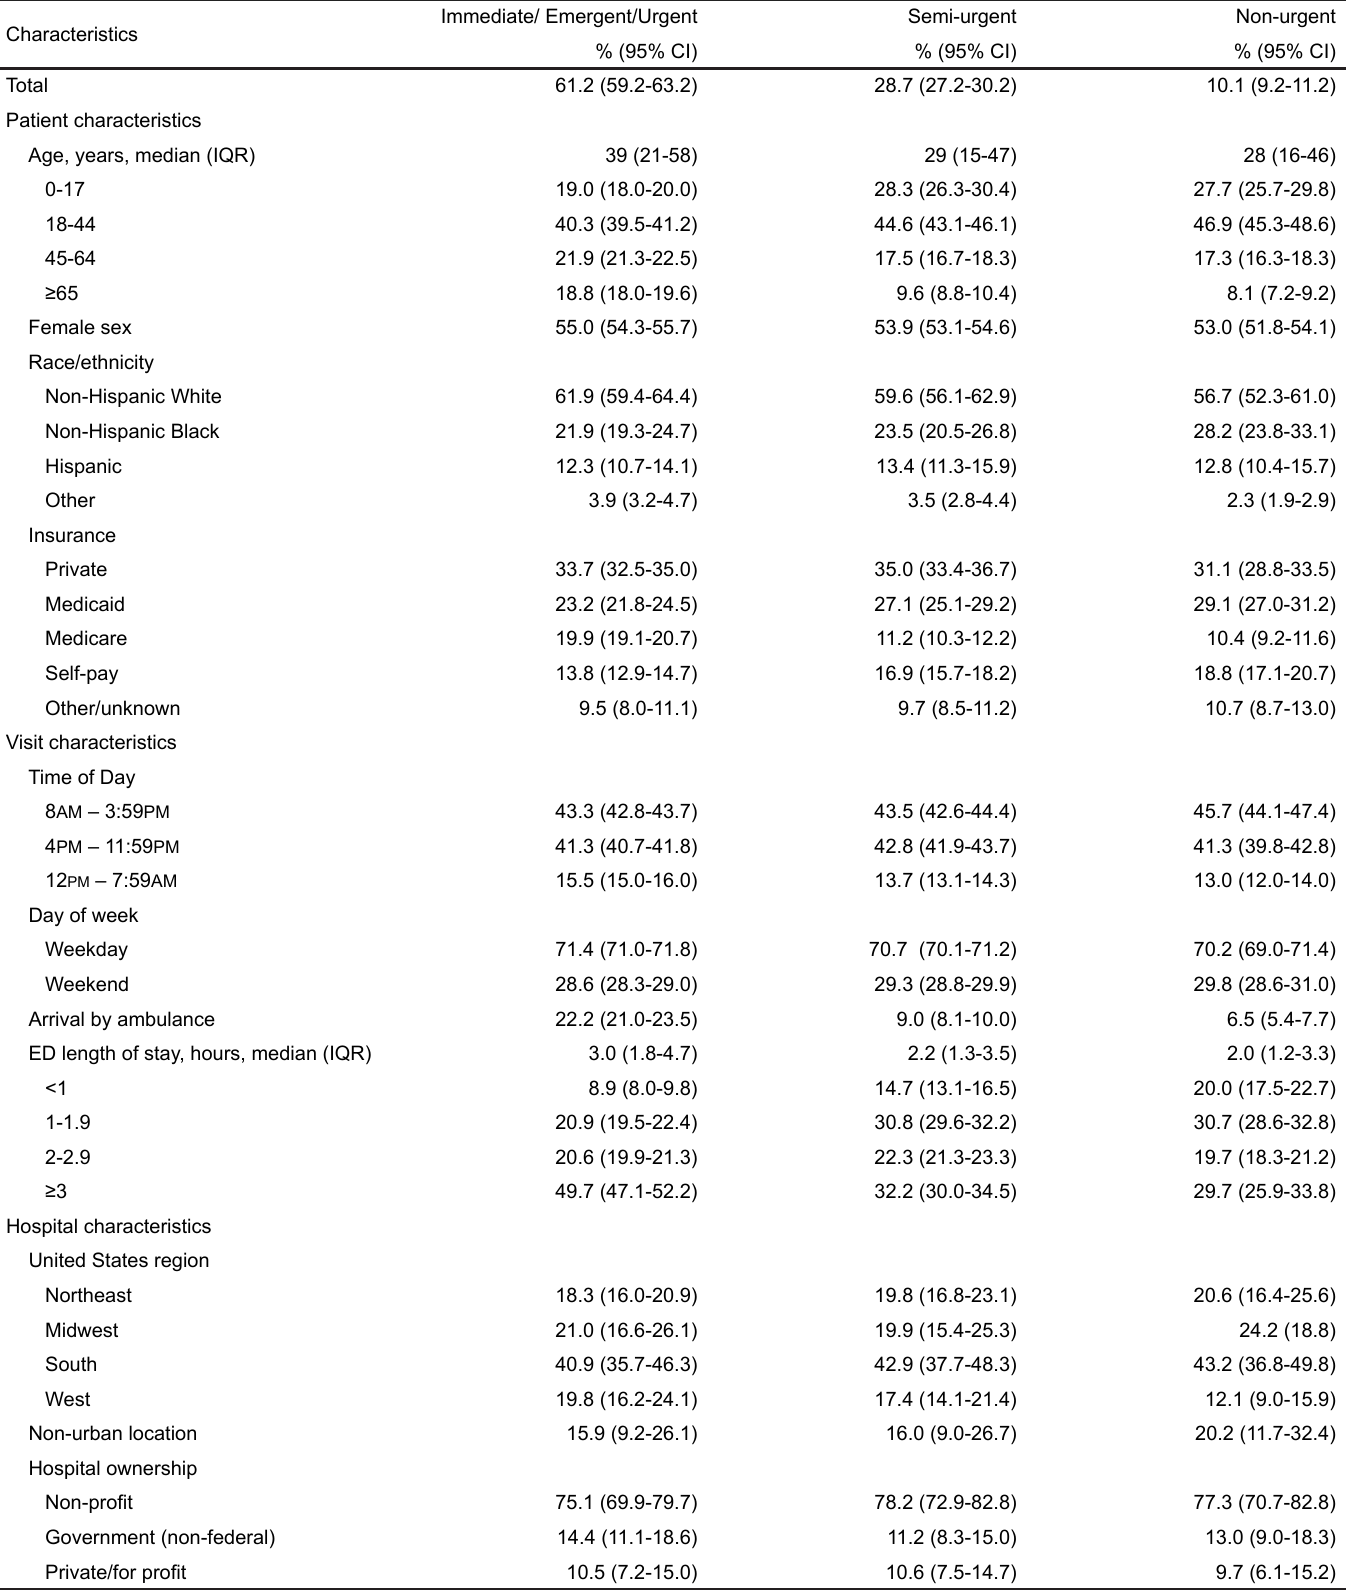
Table 1. Clinical characteristics of 2006-2009 United States emergency department (ED) visits by triage acuity.